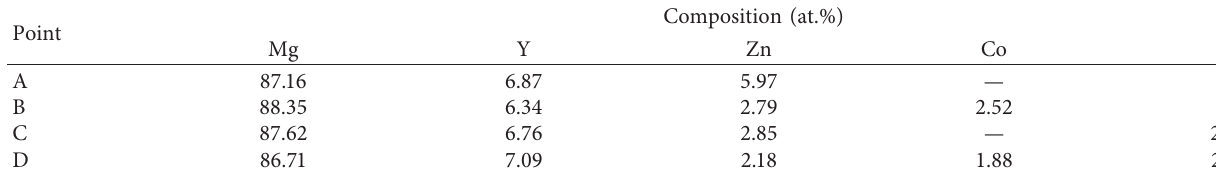
Table 2: EDS elemental analysis of the phases marked in Figure 1.